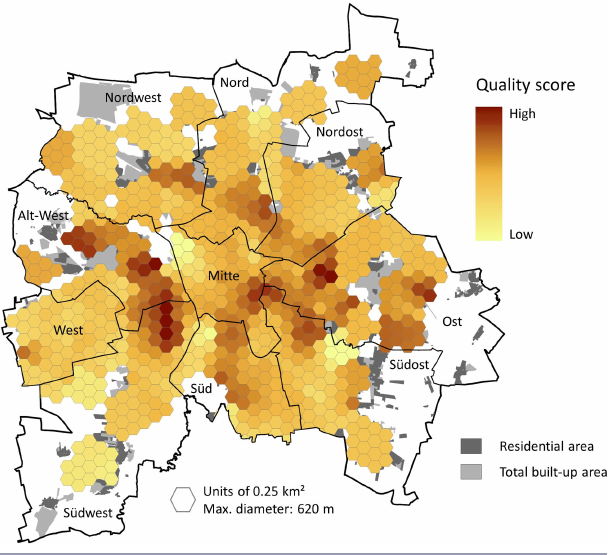
Fig. 9 . Spatial distribution of the park quality score in the City of Leipzig depicted by hexagonal units of 0.25 square kilometers. Gray shades represent built-up and residential areas in empty hexagons, i.e., that neither contain parks nor intersect the 500-m-buffer zone of any park. For better orientation, the map is overlaid by Leipzig’s major districts. For an interactive view of the map, please refer to the online GIS at https://arcg. is/0GXafX or download geodata from Kraemer and Kabisch 2021. Source of background and district data: City of Leipzig 2018 c , GeoSN 2018 a